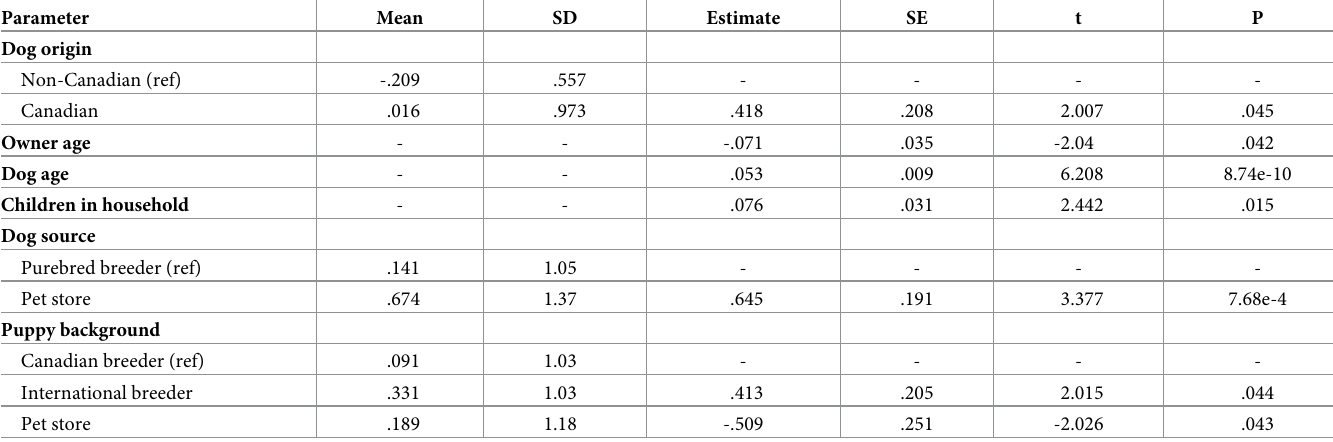
Table 12. Statistically significant interactions of owner and dog parameters on perceived health factor “Perceived health issues”.